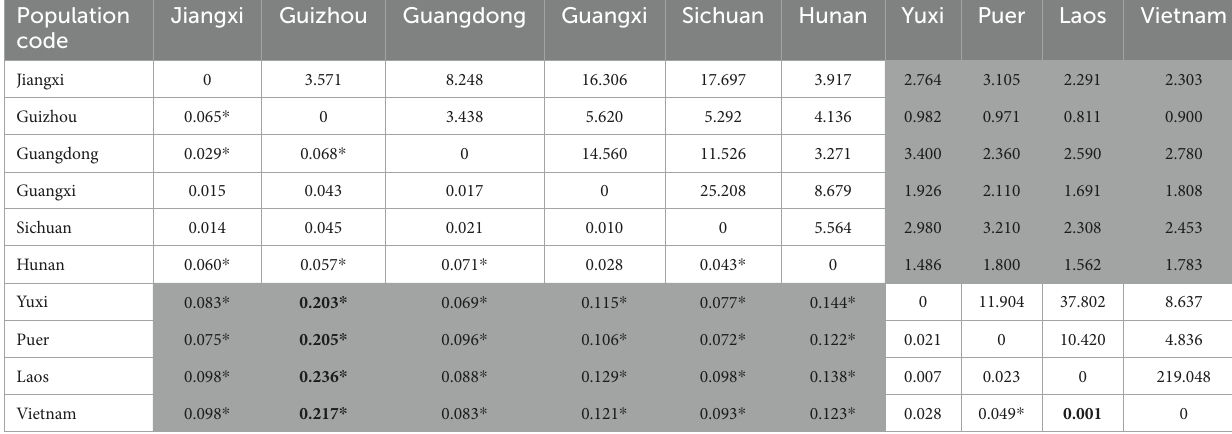
Asterisks represent level of statistical significance: * p < 0.05. The gray indicate seperate values between each population of the SE-Asia Group and each of S-China Group. FST greater than 0.2 are bolded, indicating large genetic differentiation between populations; FST equal to 0.001 is bolded, indicating minor genetic differentiation between populations.